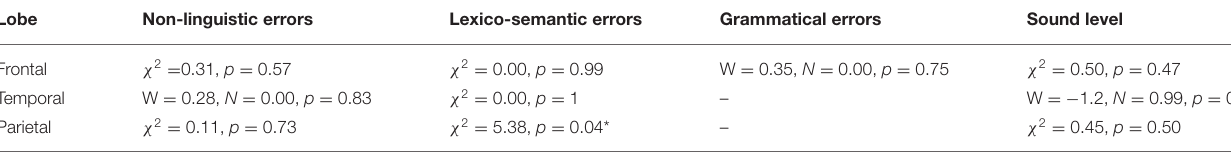
TABLE 2 | Error types elicited in the left hemisphere per